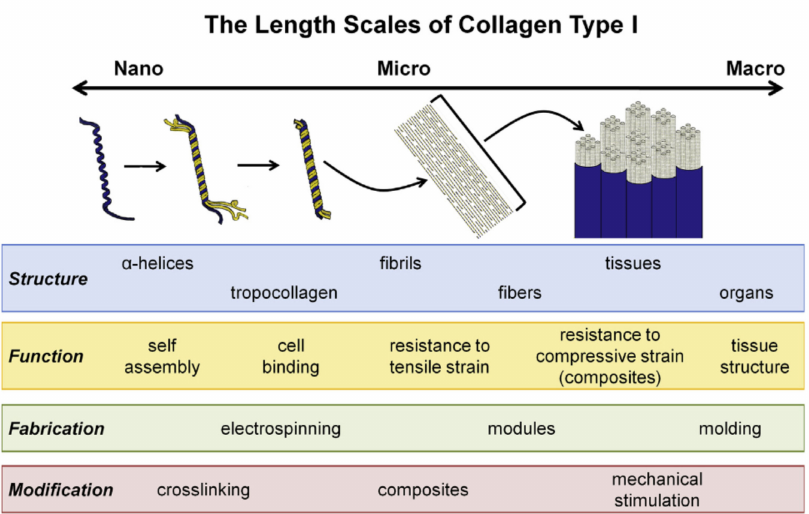
Figure 3. Representation of collagen type I structure at different scales [72]. Two of the three polypeptide chains are identical, the third has a distinct sequence of amino acids. The α -chains are composed of repeating sequences of three amino acids that have a glycine at every third interval. Glycine amino acid allows the rotational freedom that leads to the helical structure. Other amino acids are responsible for stability, rigidity, biochemical and physical characteristics of collagen